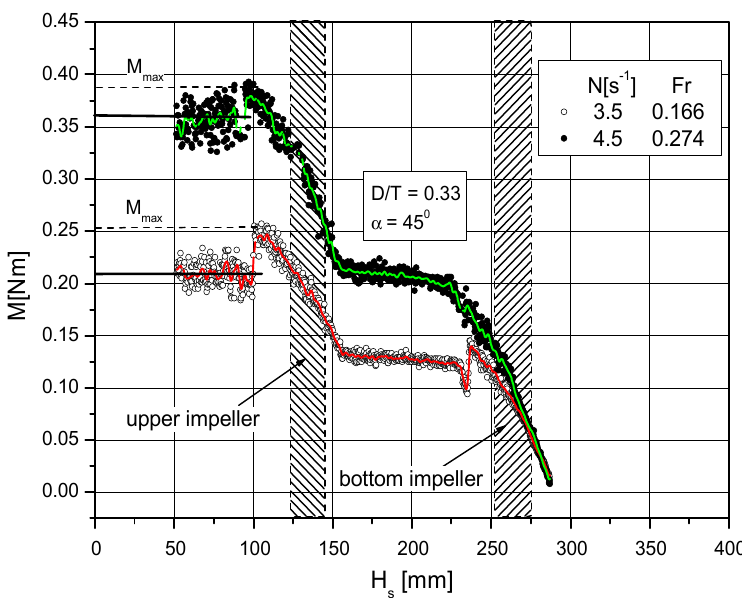
Figure 7. Increase in torque for high rotational speeds of the impellers.